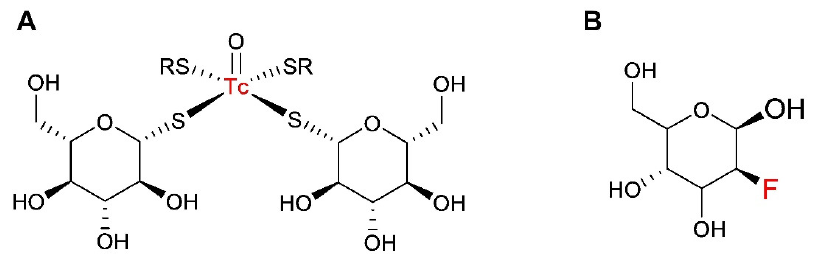
Figure 1. Schematic representation of structures of [ 99m Tc]Tc-TG ( A ) and [ 18 F]-FDG ( B ).